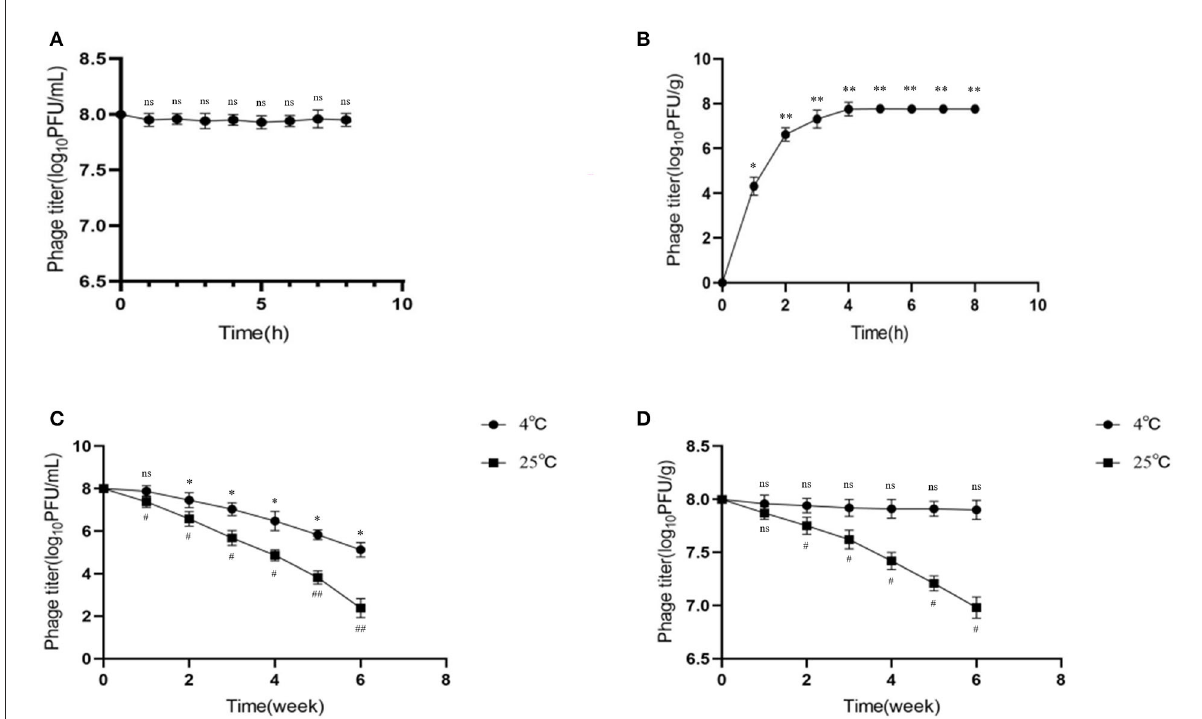
FIGURE3 Release behavior and storage stability of microencapsulated phage in simulated intestinal fluid. (A) Stability of free phage in SIF. (B) Release behavior of microencapsulated phage in SIF. (C) Effects of 4 ◦ C and 25 ◦ C on free phage. (D) Effects of 4 ◦ C and 25 ◦ C on microencapsulated phage. ns represents significantly the same ( P > 0.05); *represents significantly the different ( P < 0.05); **represents significantly the different ( P < 0.01); # represents significantly the different ( P < 0.05); ## represents significantly the different ( P < 0.01). Each value in the figure represents the mean ± SD ( n = 3).